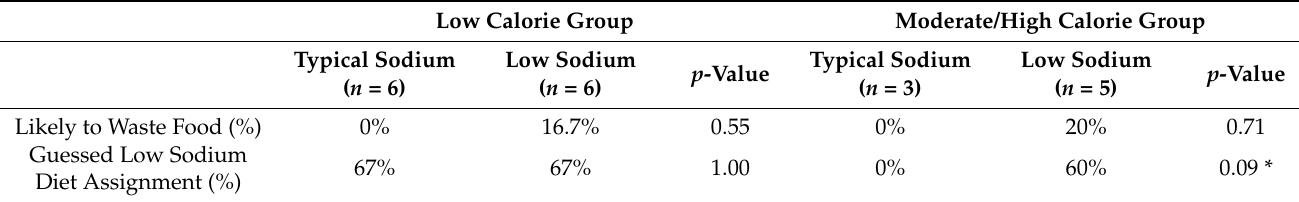
Table 5. Sustainability of meal plans by calorie